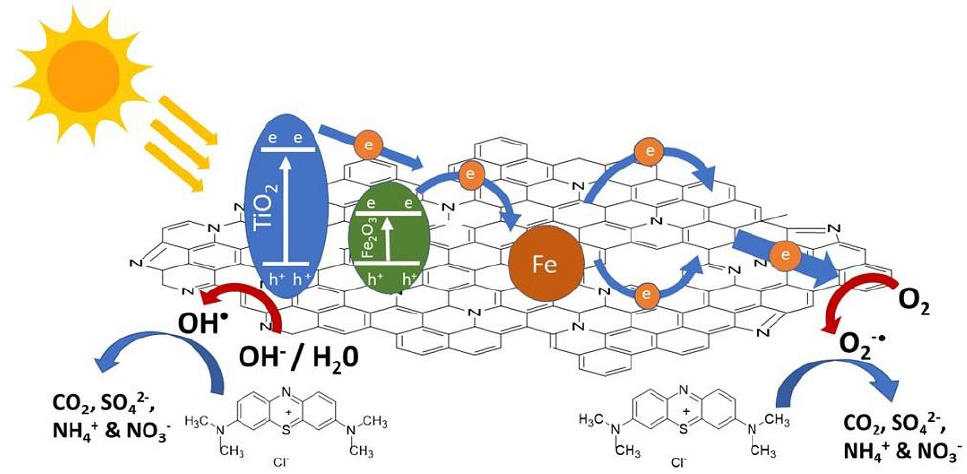
Figure 14. Mechanism of photocatalysis.